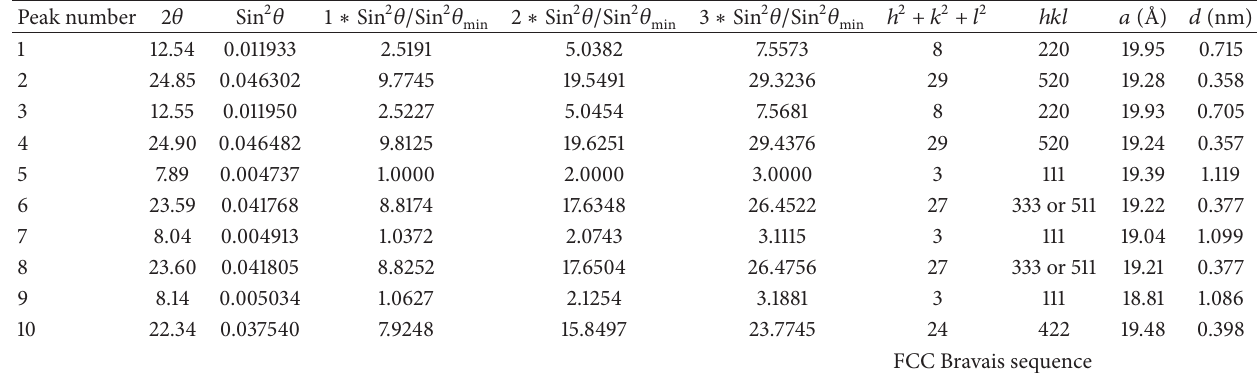
Table 4: Indexed XRD patterns.